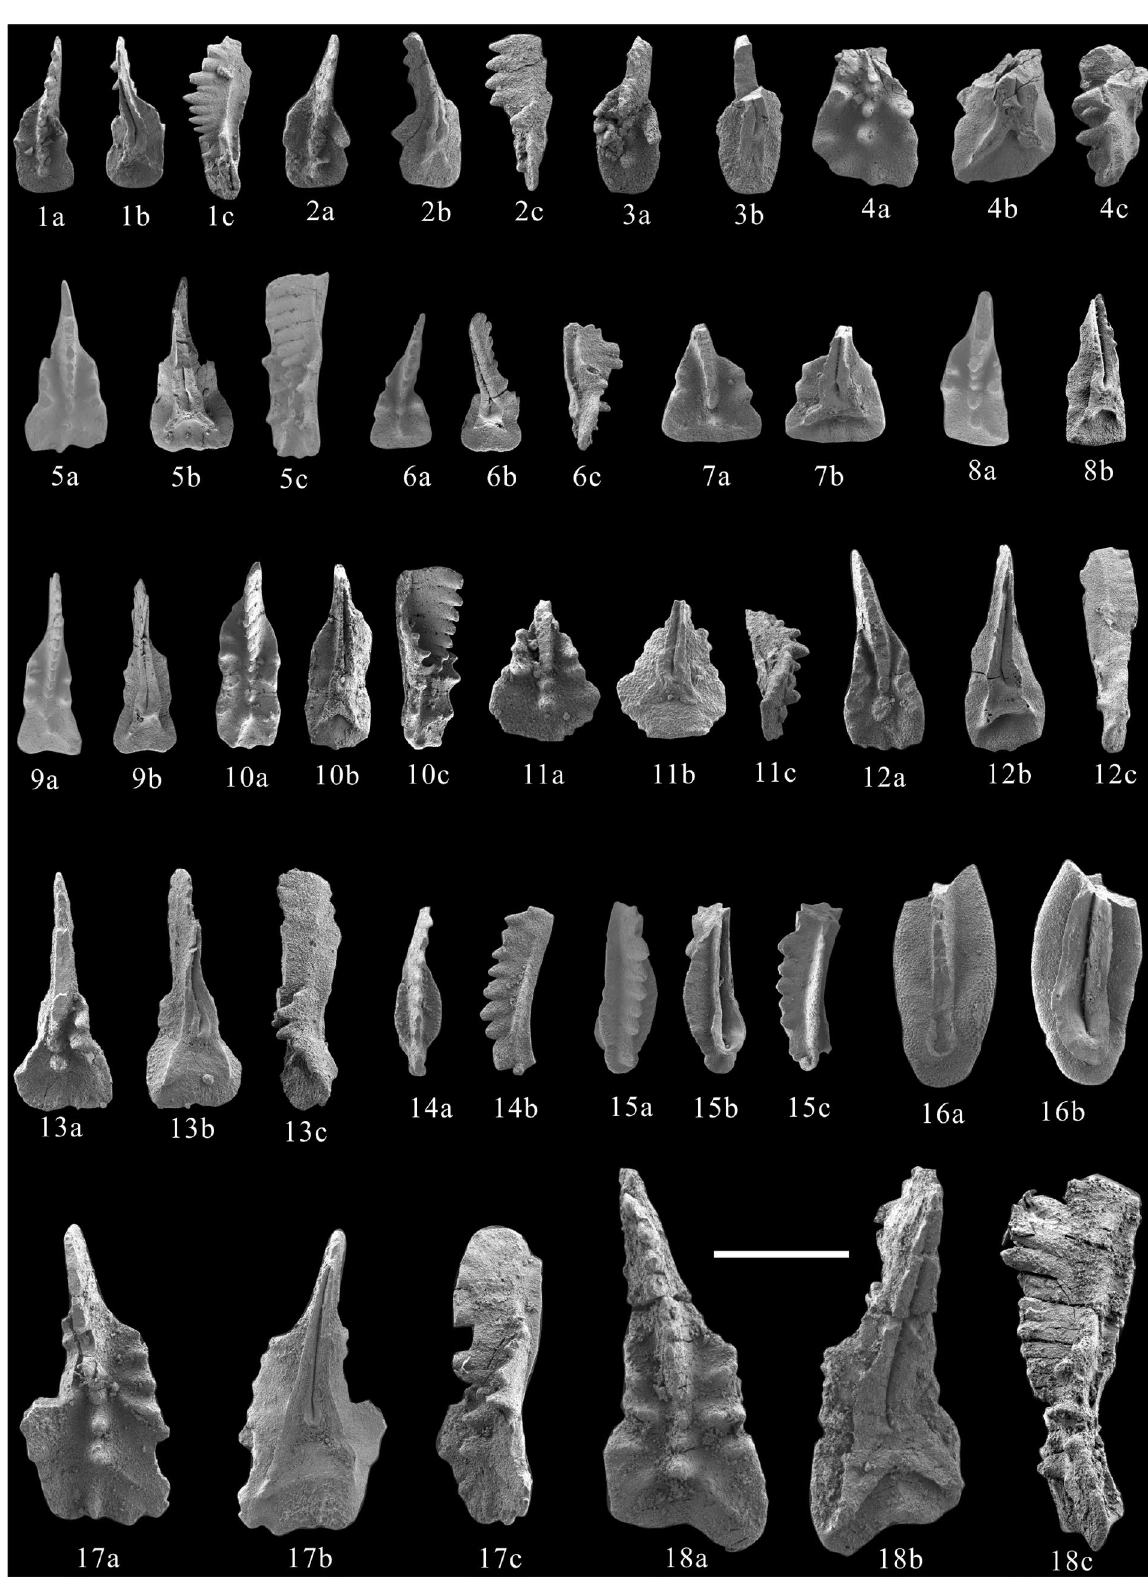
Figure 3. Norian conodonts recovered from the ZhaxicobuCo Section. Scale bar is 400 μm. 1–3 , Ancyrogondolella sp. A. 1, 130,620–10; 2, 130,620–12; 3, 130,620–49; 4–7 , 18, Ancyrogondolella rigoi . 4,